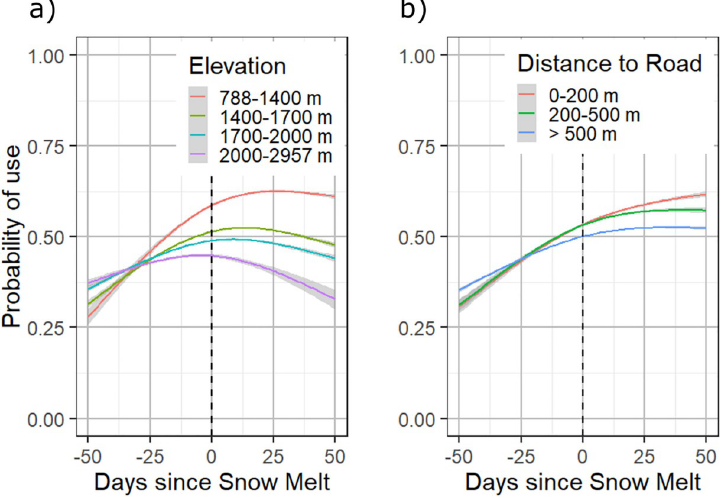
Fig 5. Probability of use calculated with DSM on the x-axis and (a) categorized by elevation (m) and (b) distance to road (m). Preference is shown for lower elevation locations, especially once snow has melted. Grizzly bears generally were more likely to select for locations closer to roads once snow has